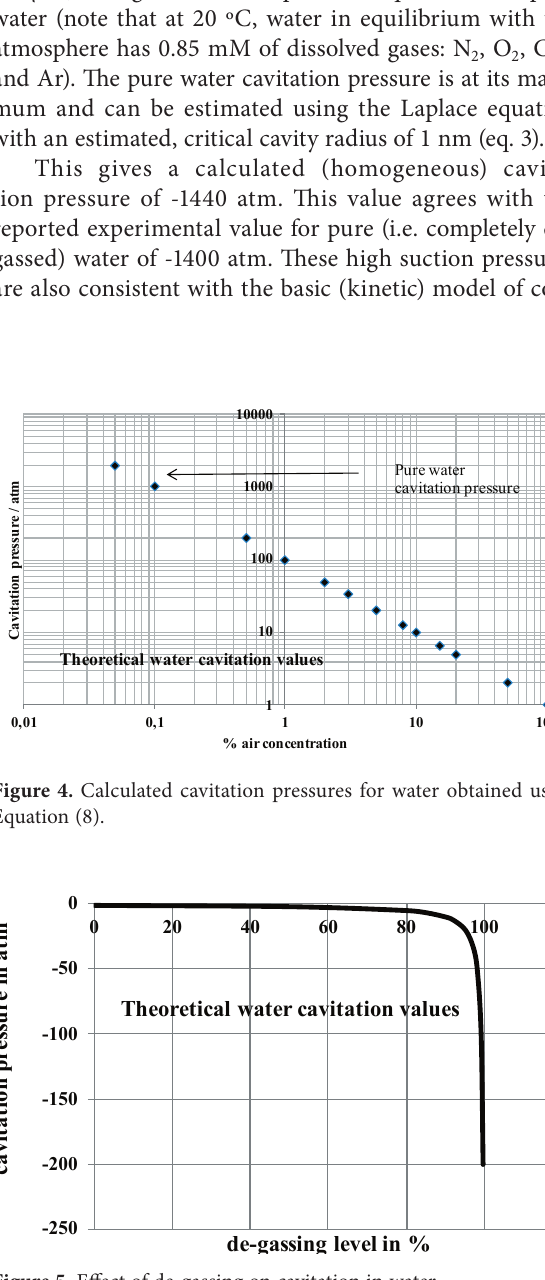
Figure 5. Effect of de-gassing on cavitation in